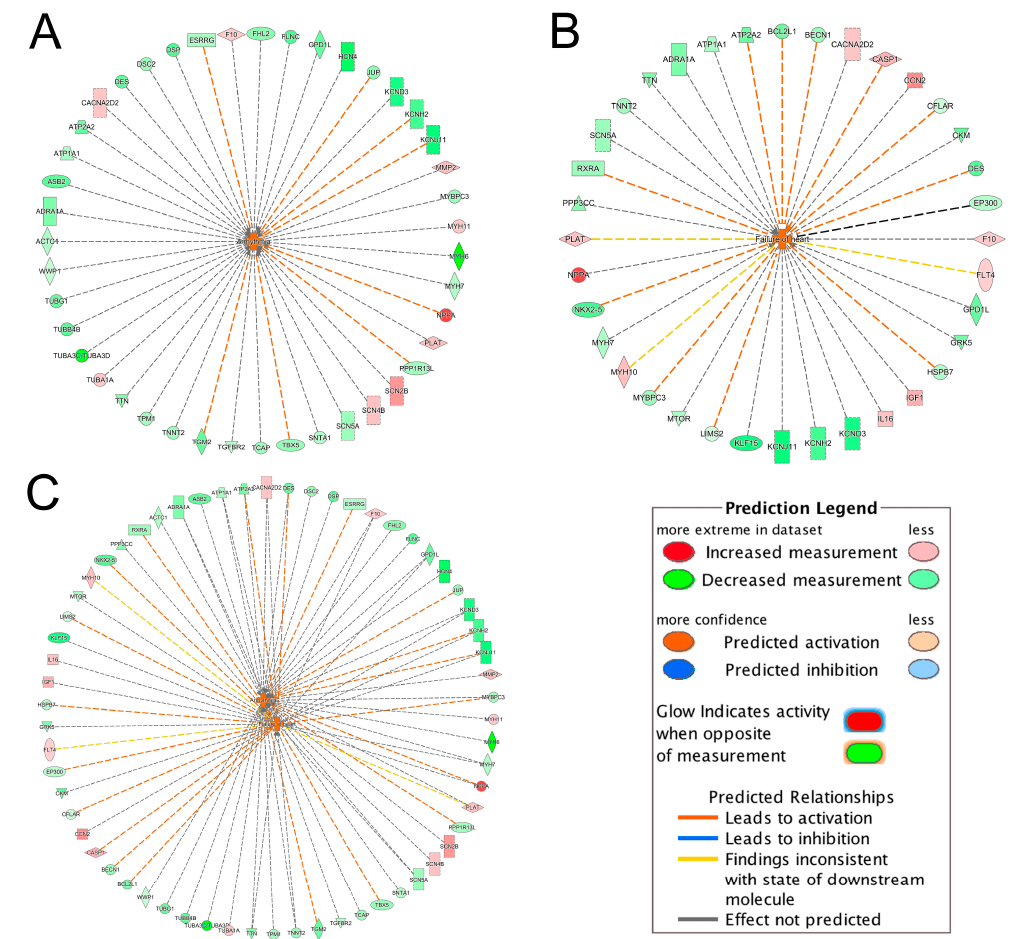
Figure 2. Interactions of significantly activated toxicity pathways with their associated DEGs. ( A ) arrhythmia; ( B ) failure of heart; ( C ) integrated toxicity pathways. For example, in Figure 2A, the gene TBX5 was downregulated as indicated by the green color and the downregulation of TBX5 further promoted (indicated by the orange dash line) the activation of arrhythmia, as indicated by the orange color. For other indicators, please refer to the Prediction Legend. Table 4. Shared DEGs between arrhythmia and failure of heart.